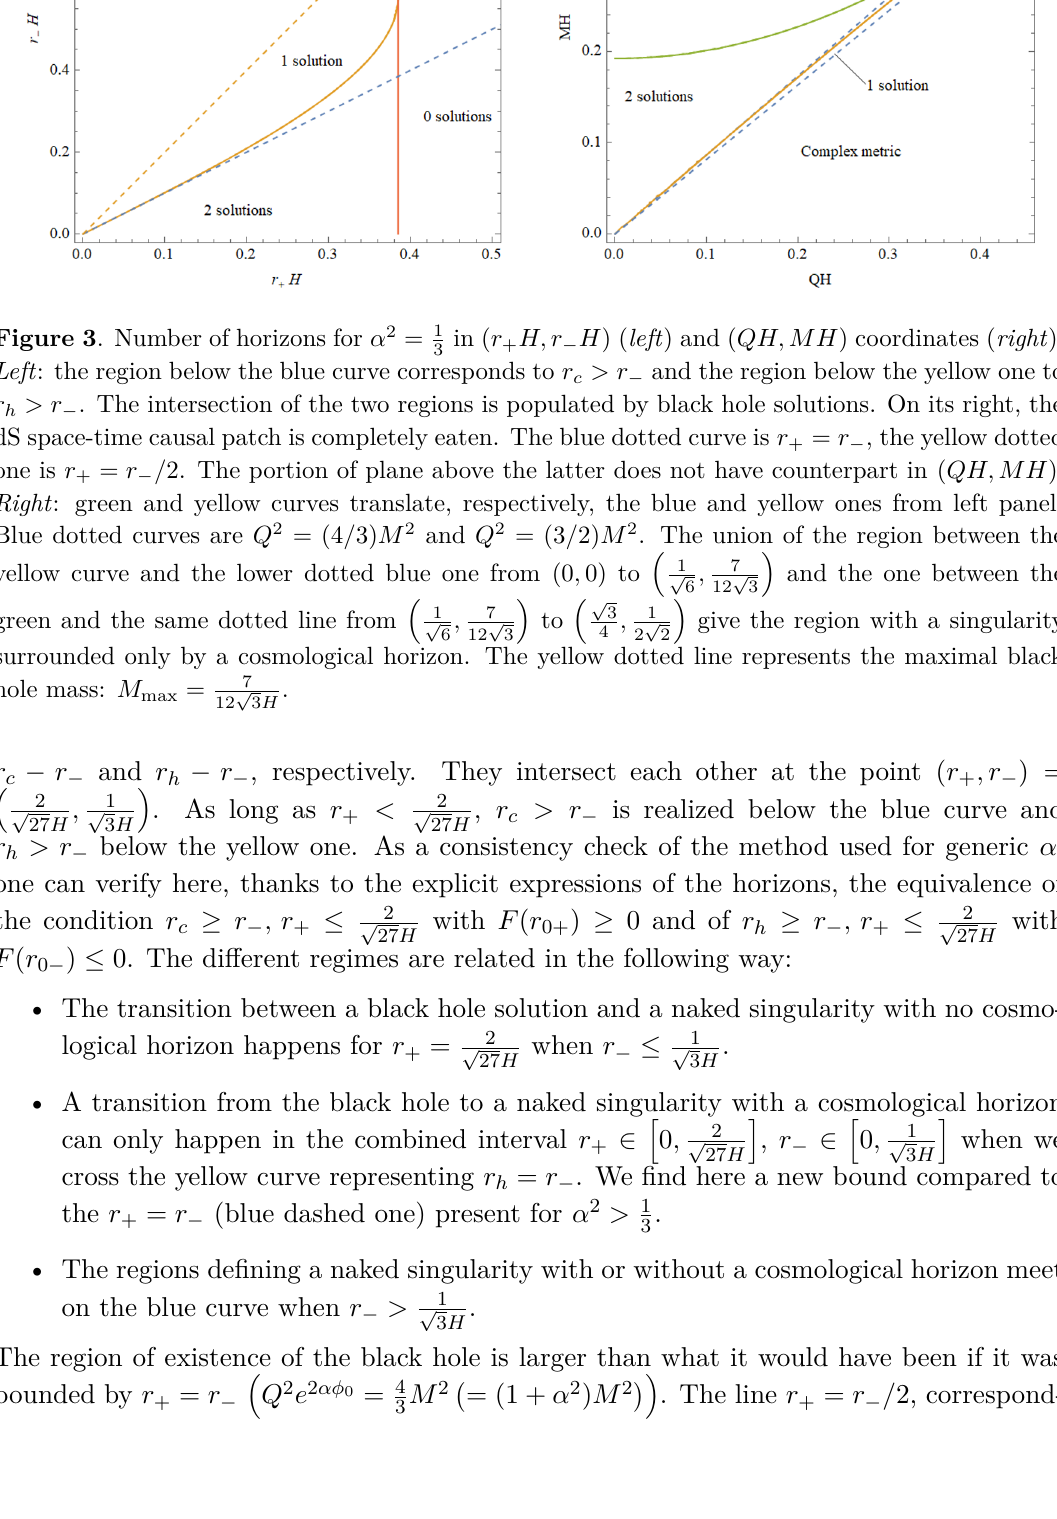
Figure 3 . Number of horizons for α 2 = 1 Left : the region below the blue curve corresponds to r c > r − and the region below the yellow one to r h > r − . The intersection of the two regions is populated by black hole solutions. On its right, the dS space-time causal patch is completely eaten. The blue dotted curve is r one is r = r 2 . The portion of plane above the latter does not have counterpart in ( QH, MH ) . + − / Right : green and yellow curves translate, respectively, the blue and yellow ones from left panel. Blue dotted curves are Q 2 = (4 / 3) M 2 and Q 2 = (3 / 2) M 2 . The union of the region between the yellow curve and the lower dotted blue one from (0 , 0) to green and the same dotted line from